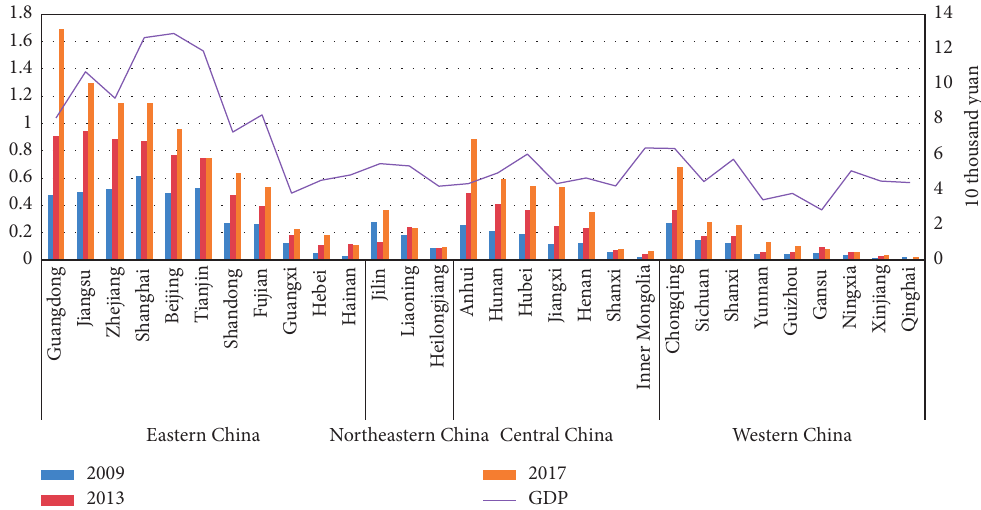
Figure 1: China’s level of ETI (2009, 2013, and 2017) and economic development level